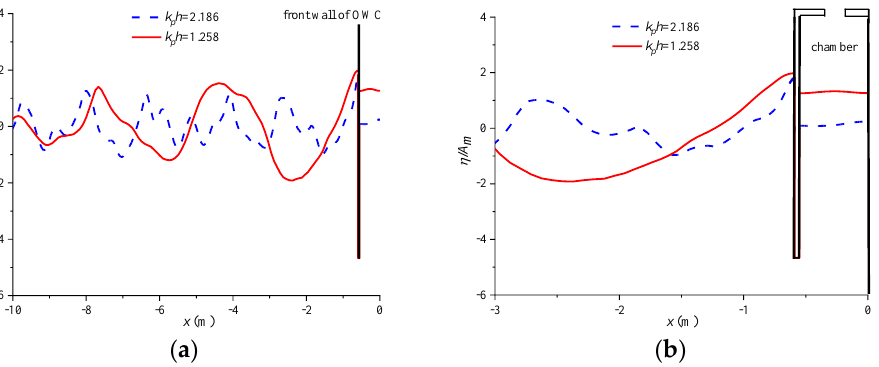
Figure 11. Profile of the free-surface elevations along the numerical wave tank when the wave crest arrives at front wall of the OWC. ( a ) Overall view, ( b ) magnified view at OWC front wall.